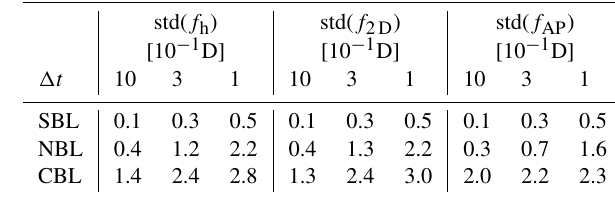
Figure 8. Scatter plot of the horizontal wake deflection in the NBL from the f 2D -fit over yaw angle γ at different downstream positions x 2 and for different averaging intervals.